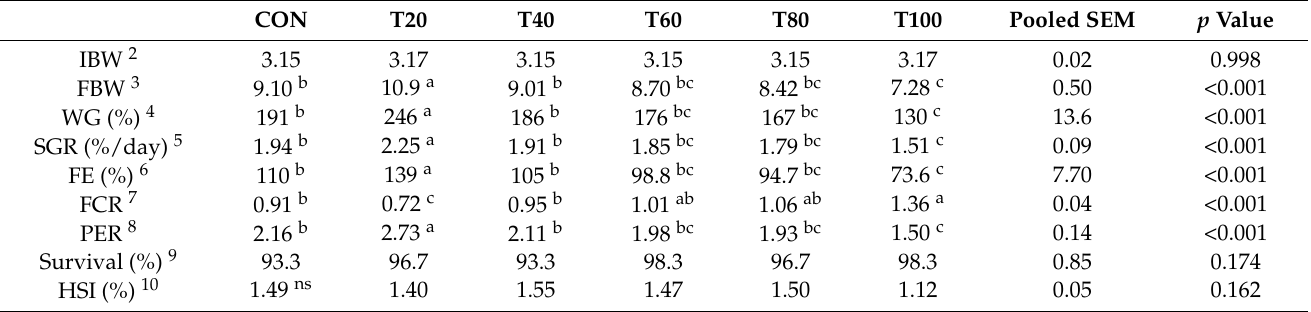
Table 4. Growth performance of juvenile rainbow trout fed the experimental diets for 8 weeks 1